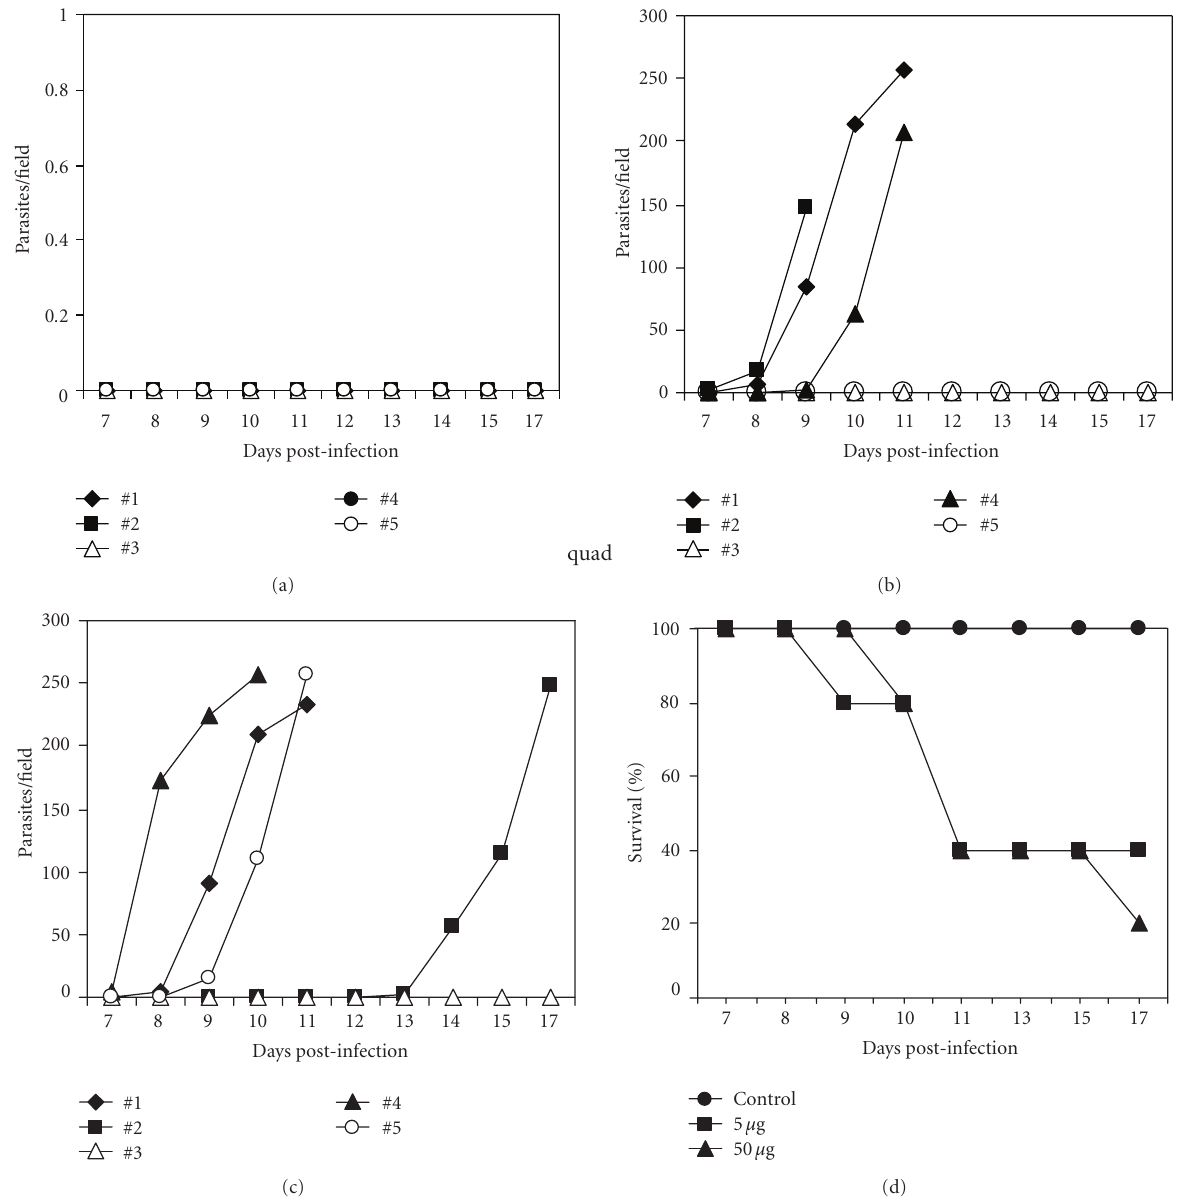
Figure 7: Immunization with TcoMSP-D amino-terminal domain resulted in increased susceptibility to infection: enhanced parasitemia and shorter survival time. Groups of 5 BALB/c mice were injected subcutaneously (s.c.) with TiterMax alone (Control), 5 μ g, or 50 μ g of